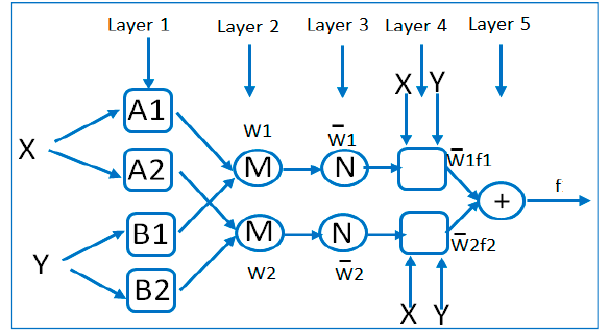
Figure 1. Structure of a five-layer ANFIS.